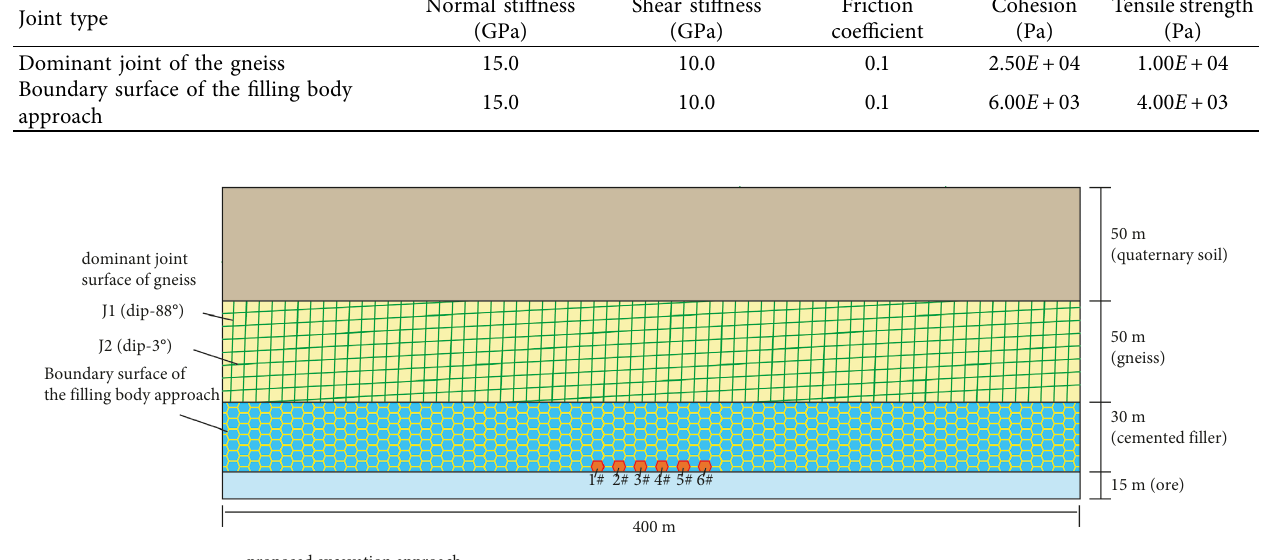
Figure 13: Schematic diagram of the simplified 11# profile.